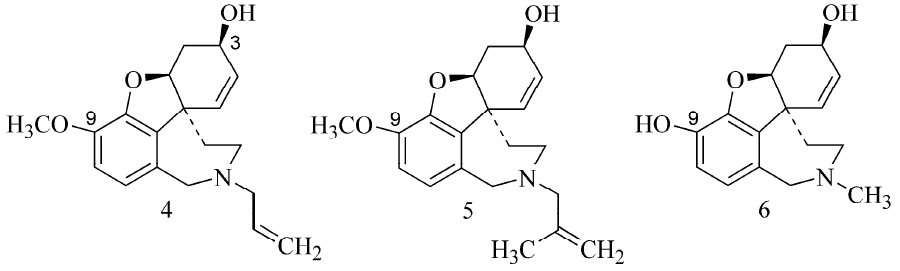
Figure 2. Chemical structures of N -allyl- nor -galanthamine ( 4 ), N -(14-methylallyl)- nor -galanthamine ( 5 ) and sanguinine ( 6 ).